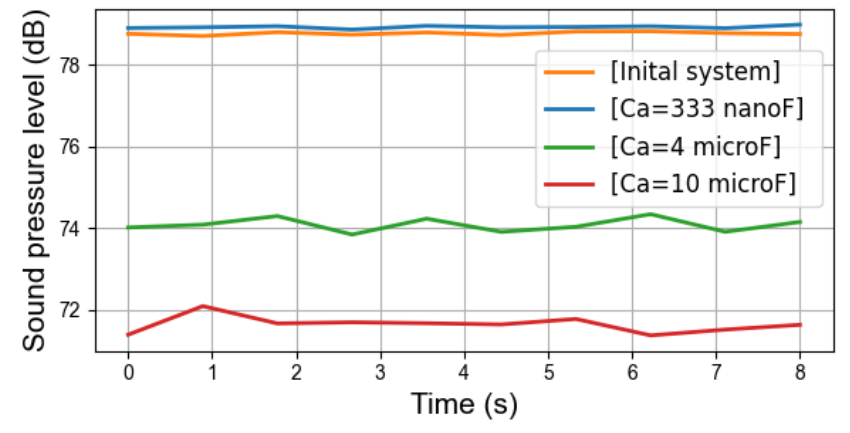
Figure 9. Global sound pressure level in dB with f swi = 3